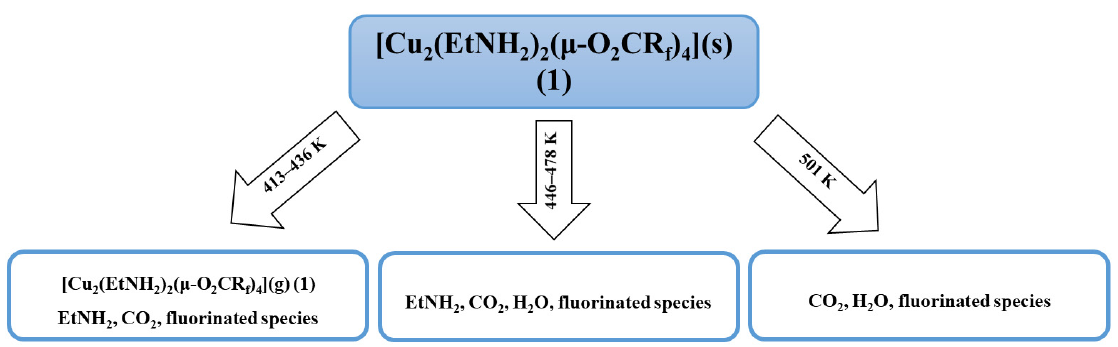
Figure 3. The thermal decomposition scheme for [Cu 2 (EtNH 2 ) 2 ( µ -O 2 CCF 3 ) 4 ] ( 1 ) proposed based on TG-IR results.